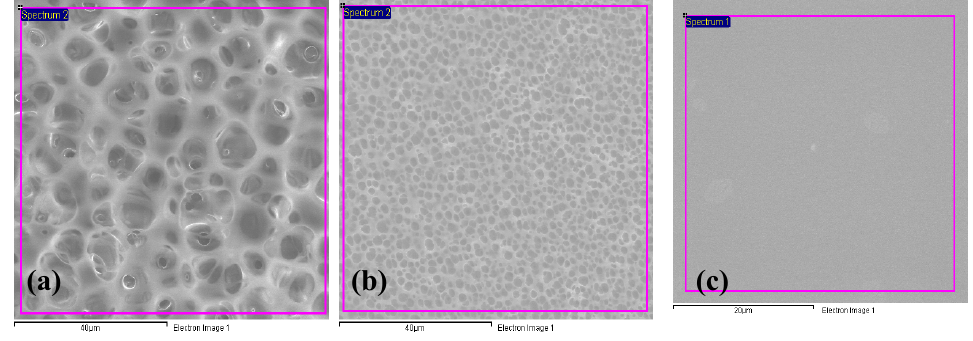
SO CF -BMATFSI. 4 3 3